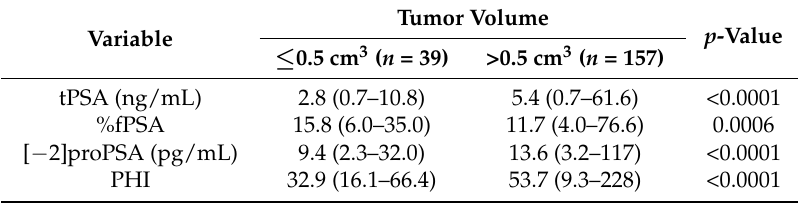
Table 3. PSA parameters (medians and ranges) in dependence on the tumor